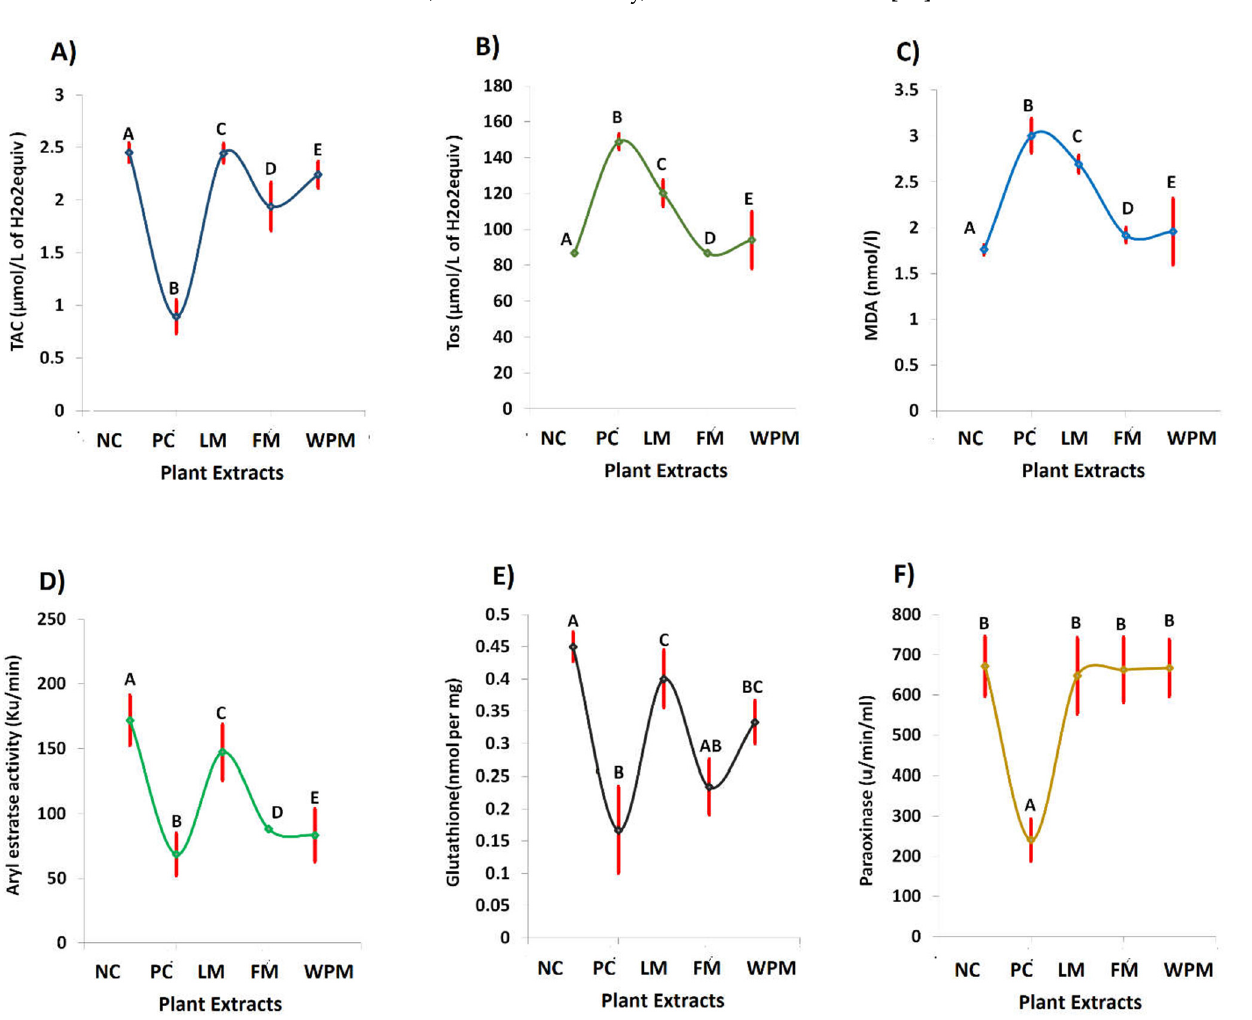
Figure 6. Effect of leaf, flower, and whole plant extract in contrast to negative and positive control (NC and PC) group on ameliorate cigarette smoke and alloxan-induced diabetes biomarkers; ( A ) total antioxidant capacity, ( B ) total oxidant status, ( C ) malondialdehyde, ( D ) arylesterase, ( E ) paraoxinase, and ( F ) glutathione. The different alphabet at chart bars showing significant difference.